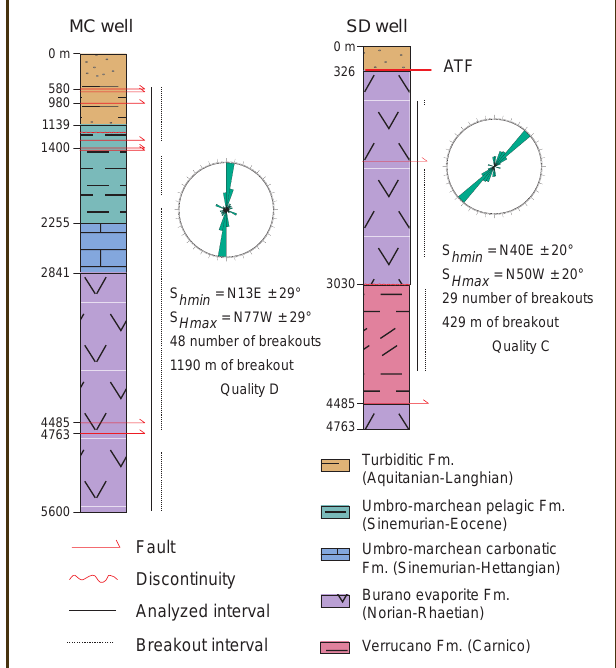
Figure 3. Stratigraphic sketch of the Monte Civitello (MC) and San Donato (SD) deep wells (see Fig. 1 for location). S hmin orientation from breakout data performed in the wells. Beside each is a rose plot with the S hmin orientation, standard deviation, the breakout’s number and length, and the quality assigned to the result (modified from Mariucci et al.,